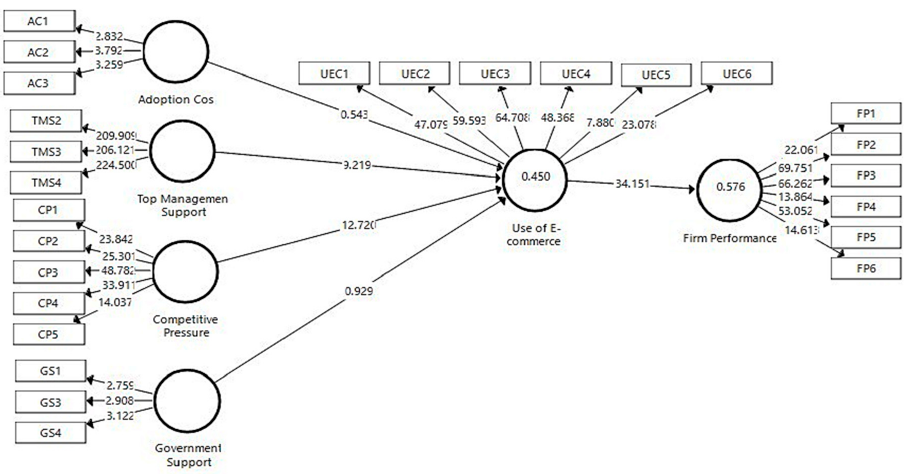
Figure 4. Assessment of structure model.